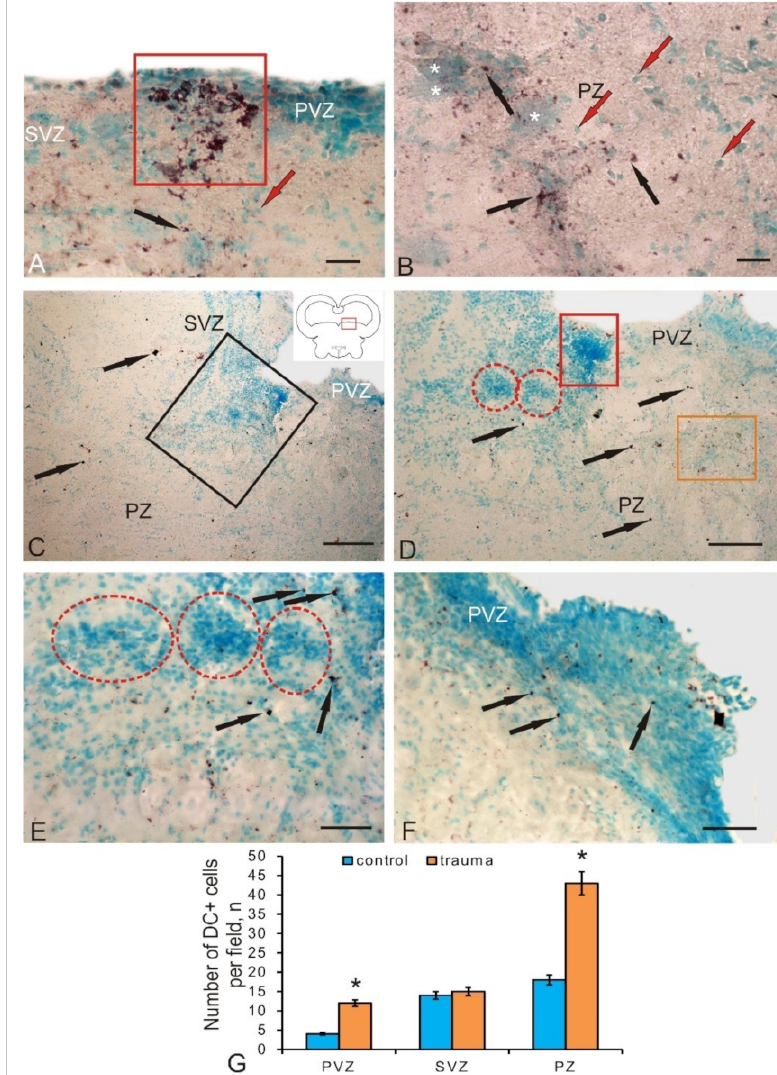
Figure 8. Localization of doublecortin in the mesencephalic tegmentum of juvenile chum salmon, Onchorhynchus keta on day 3 days post-injury. ( A ) DC expression in cells (black arrow) and PVZ cell clusters (in the red square); DC– cells (red arrow). ( B ) In the parenchymal near-injury area: large neurons of the reticular formation are indicated by white stars. ( C ) General view of the injury zone (outlined by a black rectangle). ( D ) Dorsal fragment of the injury area: hypertrophy of DC– cells stained with methyl green (in a red rectangle), reactive neurogenic niches (in red dotted ovals), and DC + neuroblasts in the PZ adjacent to the injury area (in an orange rectangle). ( E ) A ventral fragment of the injury area at high magnification. ( F ) Hypertrophied neuroepithelium in PVZ, containing numerous DC + neuroblasts. IHC doublecortin labeling in combination with methyl green staining. ( G ) The quantitative ratio of DC + cells in the control and after traumatic injury ( n = 5 in each group; * p ≤ 0.05, significant di ff erence vs. control groups); Student–Newman–Keuls test. Scale bar: (A,B) = 20 µ m; (C) = 200 µ m; (D) = 100 µ m; (E,F) = 50 µ